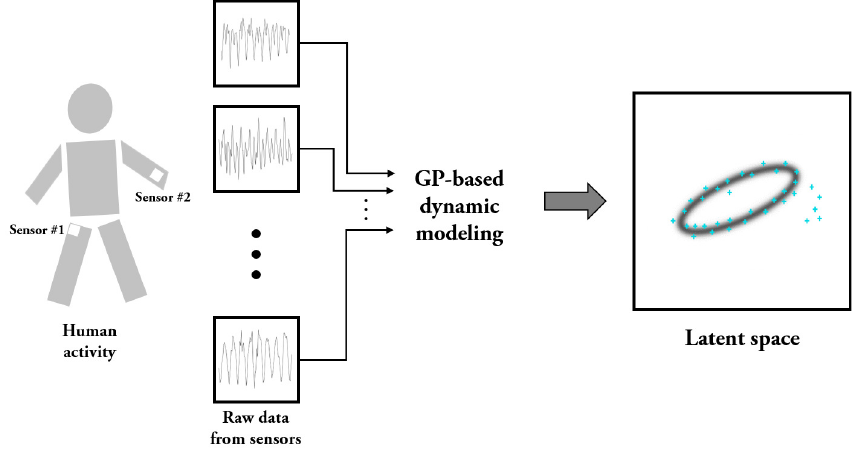
Figure 1. Schematic diagram for representing dynamic walking patterns in a latent